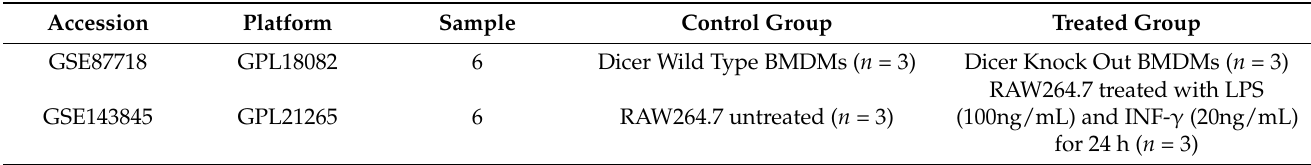
Table 1. Detailed information of the GSE87718 and GSE143845 datasets.